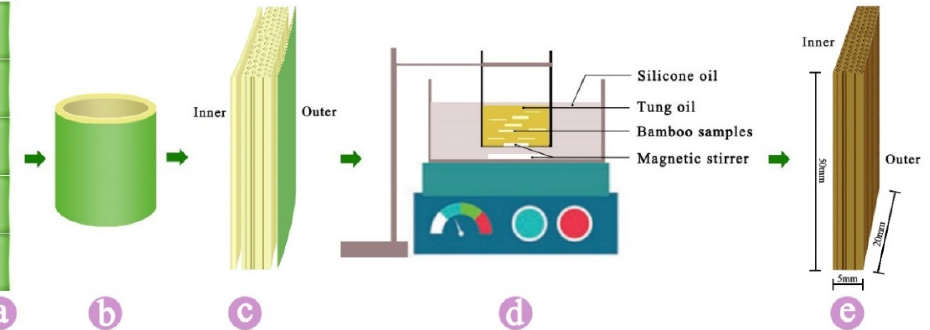
Figure 1. Schematic presentation of sample preparation. ( a ) Moso bamboo, ( b ) bamboo culm, ( c ) bamboo sample, ( d ) bamboo thermal treatment with tung oil and ( e ) bamboo